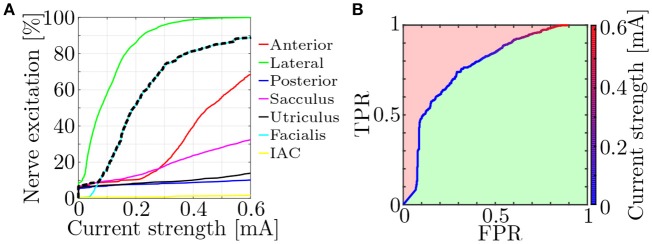
(A) Exemplary fiber recruitment curves (Hayden et al., 2011) resulting from a monopolar, EL electrode near the lateral ampullary nerve and (B) the corresponding ROC curve. Based on the dashed, black line in (A), which depicts the highest percentage of excited non-target nerves, the FPR is computed. The green space in (B) represents the AUC and is used as a measure for the worst-case selectivity of the electrode configuration.